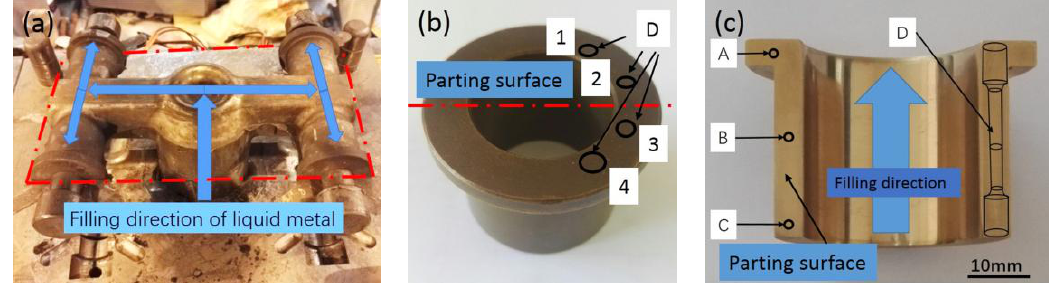
Figure 3. Mold map and the product of ZCuSn10P1 alloy: ( a ) mold map; and ( b , c ) squeeze part (A, B and C are sampling positions for microstructure observation, while D is sampling position and shape for tensile test, 1 to 4 are sampling positions for tensile test from above the parting surface to below the parting surface).